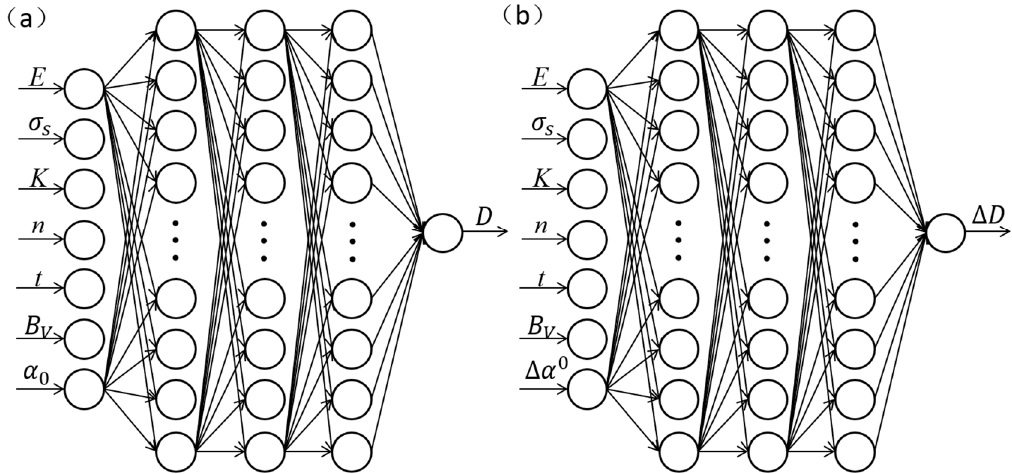
Figure 1. Structural diagram of BPNN: ( a ) punch stroke prediction model and ( b ) bending correction model.